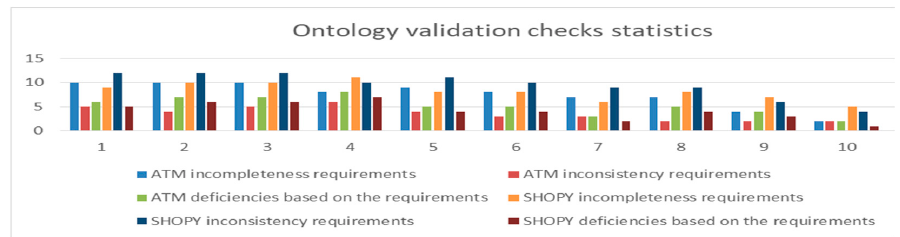
Figure 7. Validation statistics in ATM and Shopy use cases.